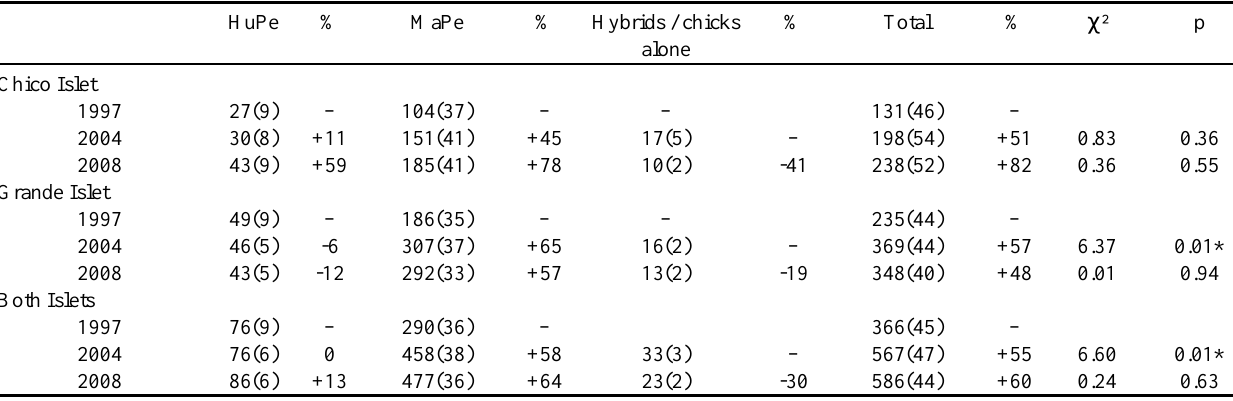
Table 2 . Observed frequencies, chi-square test, and p-values for 2 × 2 contingency tables (df = 1) for 1997-2004 and 2004-2008 reveal changes in the proportion and increase in number of burrows through the years for Humboldt Penguin (HuPe; Spheniscus humboldti ) and Magellanic Penguin (MaPe; Spheniscus magellanicus ) in Puñihuil Islets, Chiloé, Chile. Percentages were calculated based on data from 1997. Proportions from all burrows counted for particular years and islets are indicated in parentheses. Significant values are highlighted by an asterisk (*). Data for 1997 was taken from Simeone and Schlatter (1998). HuPe % MaPe